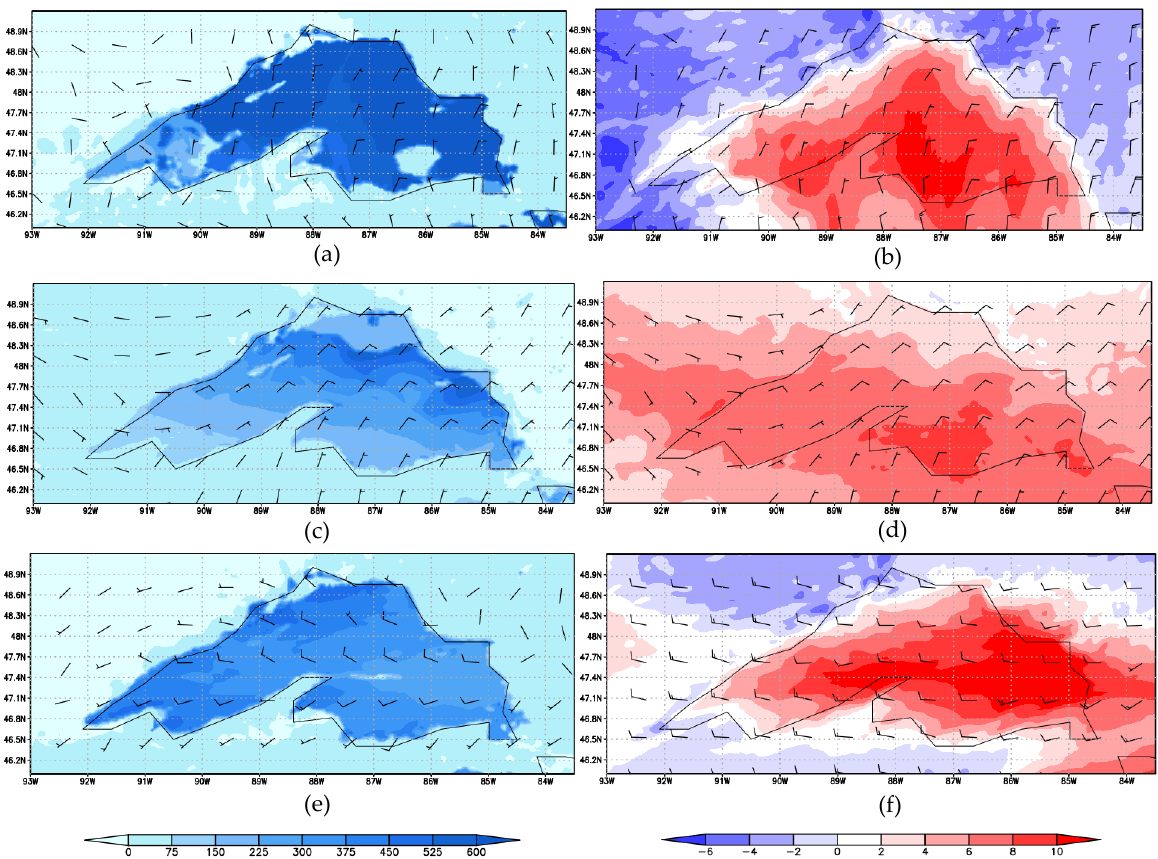
Figure 11. WRF-ARW simulated enthalpy flux (W m − 2 )/10-m surface winds (m s − 1 ) and for Cluster 1 ( a ), Cluster 2 ( c ), and Cluster 3 ( e ); surface-850 lapse rate ( ◦ C km − 1 )/925 mb winds (m s − 1 ) during peak LES activity for Cluster 1 ( b ), Cluster 2 ( d ), and Cluster 3 ( f ). A half and full wind bard represents 5 and 10 m s − 1 ,